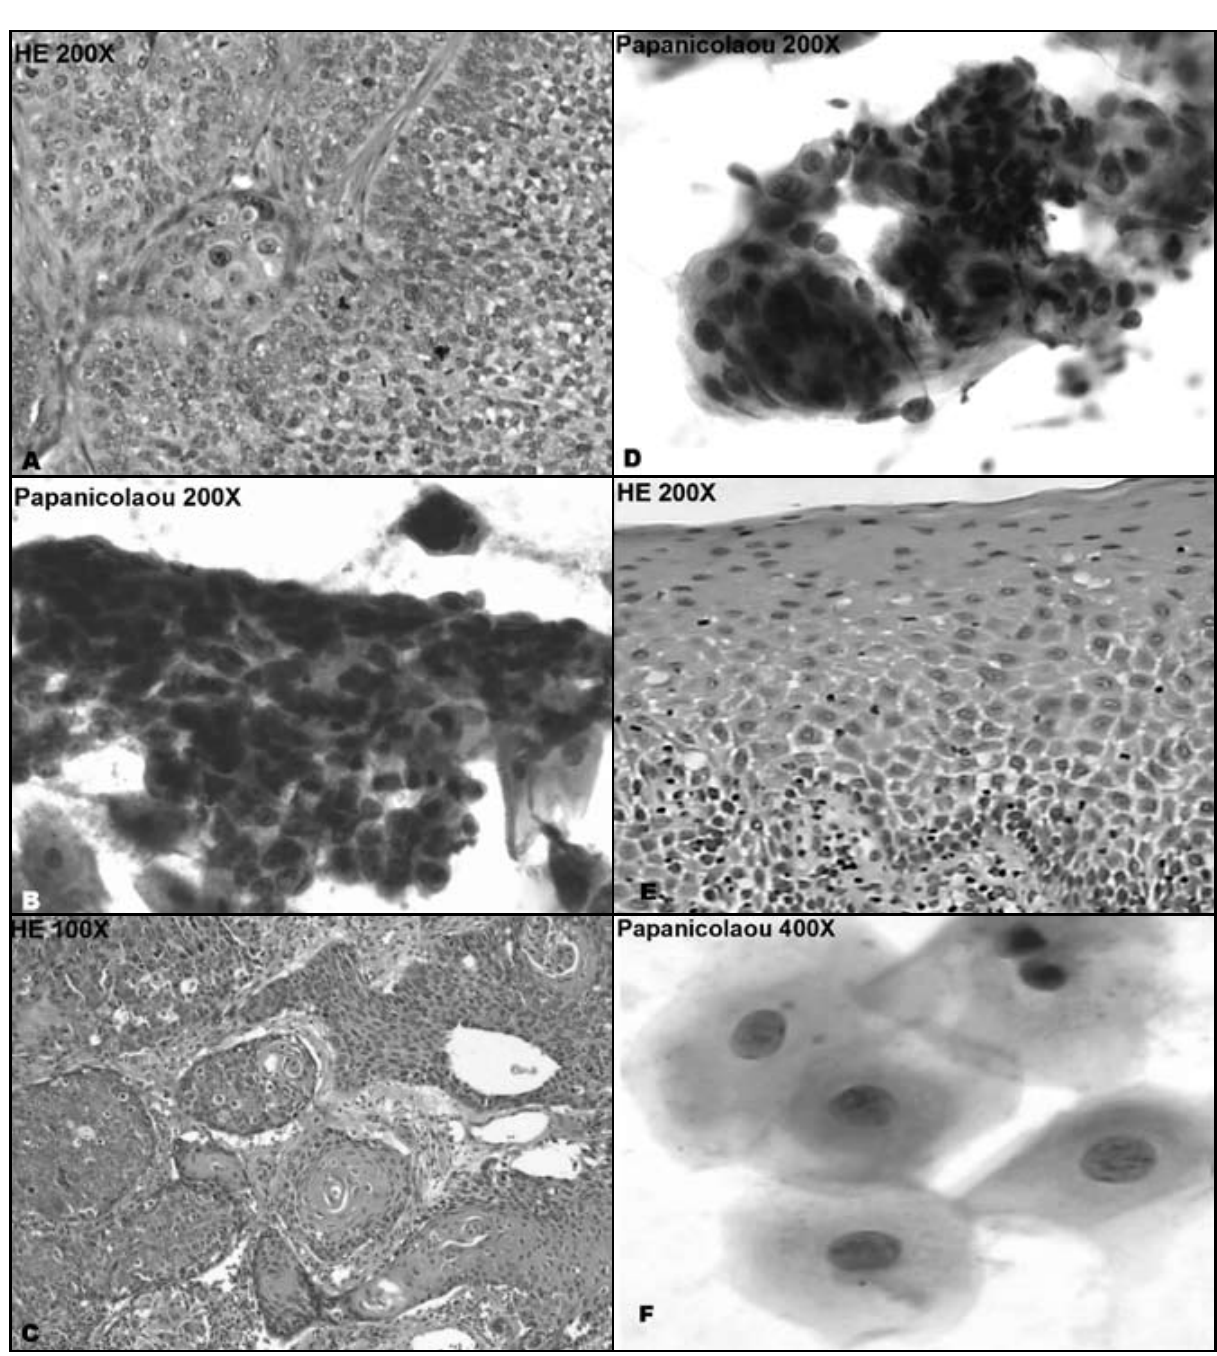
Figura 1A – Histopatologia: ninhos de células epiteliais escamosas atípicas entremeadas por conjuntivo denso, exibindo aumento da relação núcleo-citoplasma, graus variados de pleomorfismo nuclear e mitoses atípicas, correspondentes a carcinoma de células escamosas moderadamente diferenciado. Coloração por hematoxilina-eosina (HE), aumento inicial de 200x. B – Citopatologia: esfregaço correspondente ao raspado da lesão apresentando grupamento de células escamosas atípicas e exibindo aumento da relação núcleo- citoplasma, citoplasma denso, hipercromasia nuclear, cariomegalia, anisocariose, membrana nuclear irregular e nucléolo evidente, correspondentes a carcinoma de células escamosas. Coloração por Papanicolaou, aumento inicial de 200x. C – Histopatologia: células epiteliais escamosas atípicas entremeadas por conjuntivo denso e exibindo aumento da relação núcleo-citoplasma, centralizadas por pérolas de queratina, correspondente a carcinoma de células escamosas. Coloração por HE, aumento inicial de 100x. D – Citopatologia: esfregaço correspondente ao raspado da lesão apresentando grupamento de células epiteliais com alteração da relação núcleo-citoplasma, citoplasma denso e cariomegalia. Aspectos sugestivos de carcinoma de células escamosas. Coloração por Papanicolaou, aumento inicial de 200x. E – Histopatologia: fragmento de mucosa apresentando epitélio escamoso estratificado paraqueratinizado, acantose, espongiose e leve exocitose. No conjuntivo subepitelial observa-se leve infiltrado inflamatório mononuclear, configurando aspectos de mucosite inespecífica. Coloração por HE, aumento inicial de 200x. F – Citopatologia: esfregaço correspondente ao raspado da lesão apresentando células escamosas típicas, sem aspectos citopatológicos de malignidade. Coloração por Papanicolaou, aumento inicial de